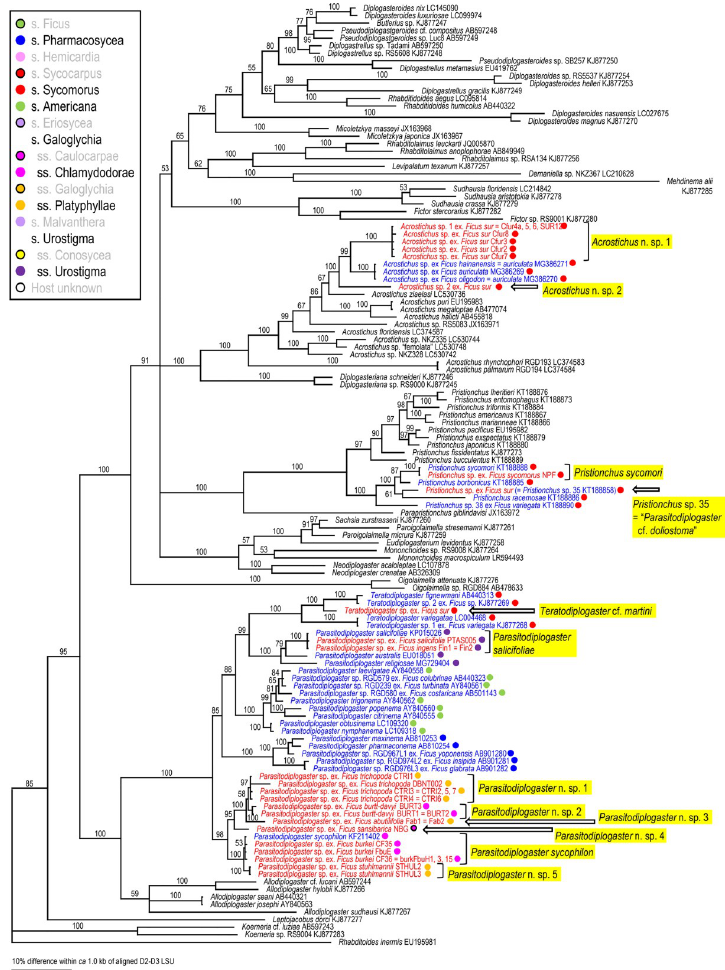
Fig 6. Phylogenetic status of fig-associated species within the family Diplogastridae inferred from D2-D3 LSU under GTR + G + I model. The parameters are: AIC = 55649.066, lnL = -27559.395, freqA = 0.20, freqC = 0.22, freqG = 0.33, freqT = 0.25, R(a) = 0.53, R(b) = 1.92, R(c) = 0.89, R(d) = 0.50, R(e) = 3.51, R(f) = 1.00, Pinva = 0.21, Shape = 0.94. Posterior probability values exceeding 50% are given on appropriate clades. Fig-associated nematode species obtained in the present study and previous studies are written in red and blue, respectively. Section or subsection of host fig species are coded with color dots.